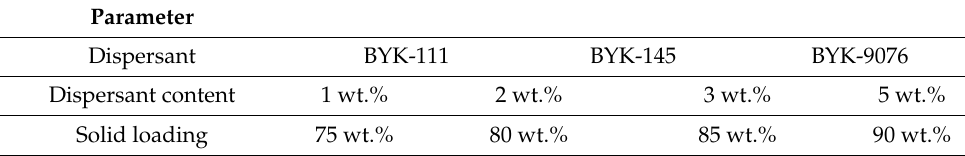
Table 2. Investigated slurry preparation